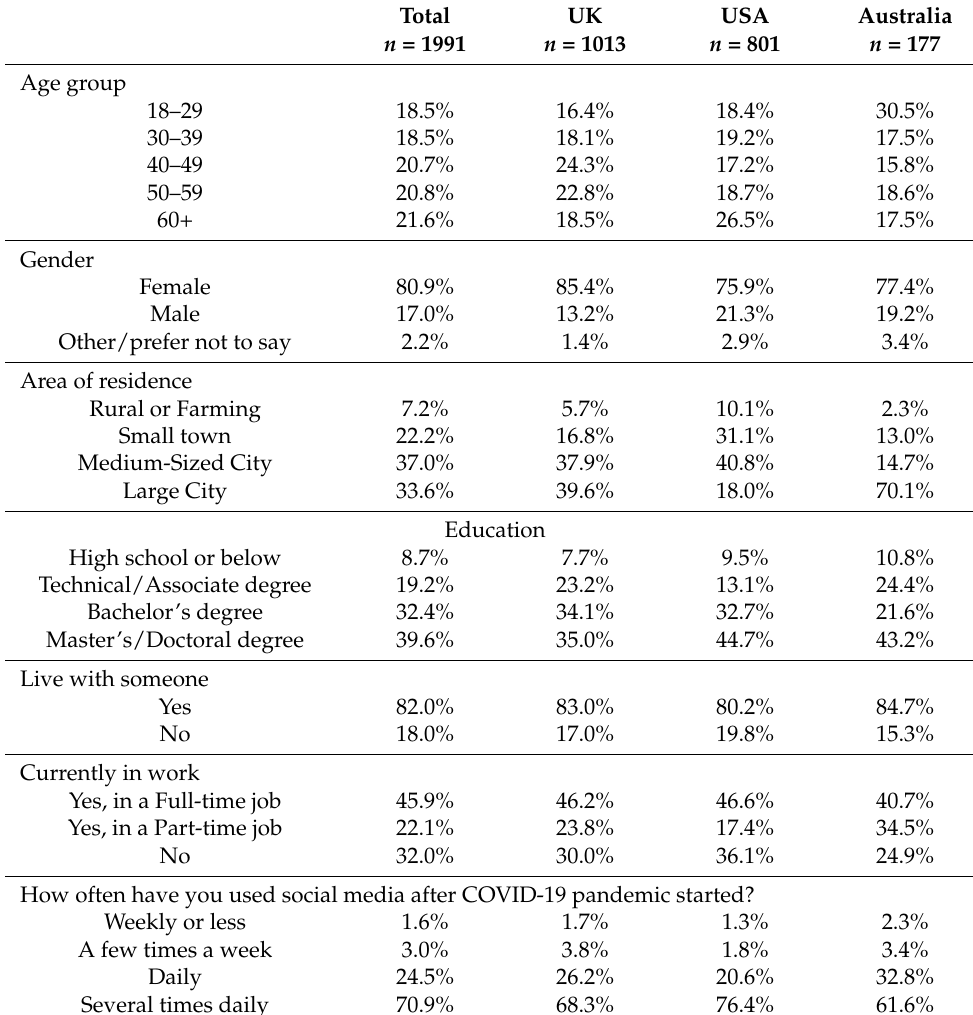
Table 2. Participants